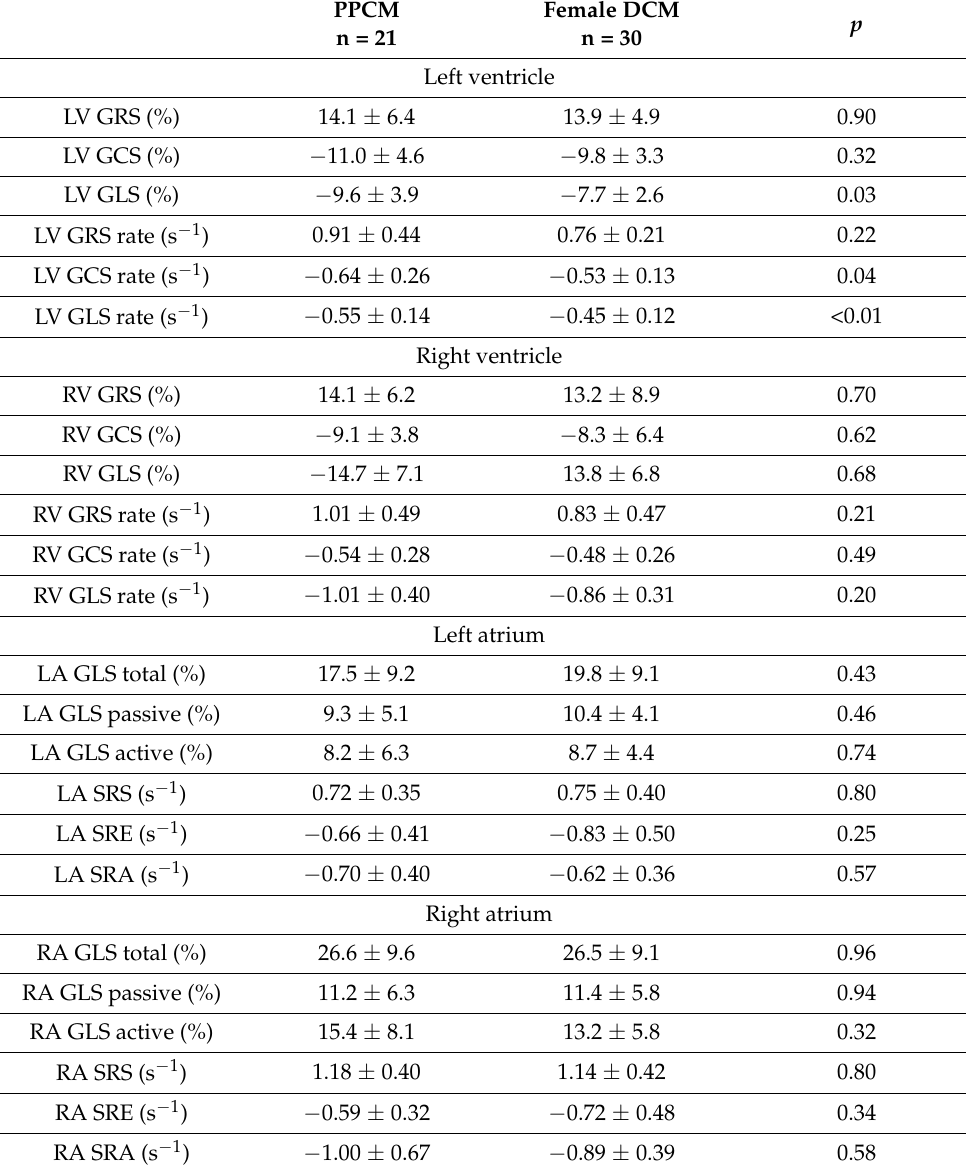
Table 2. CMR-FT derived strain parameters in patients with PPCM and female patients with